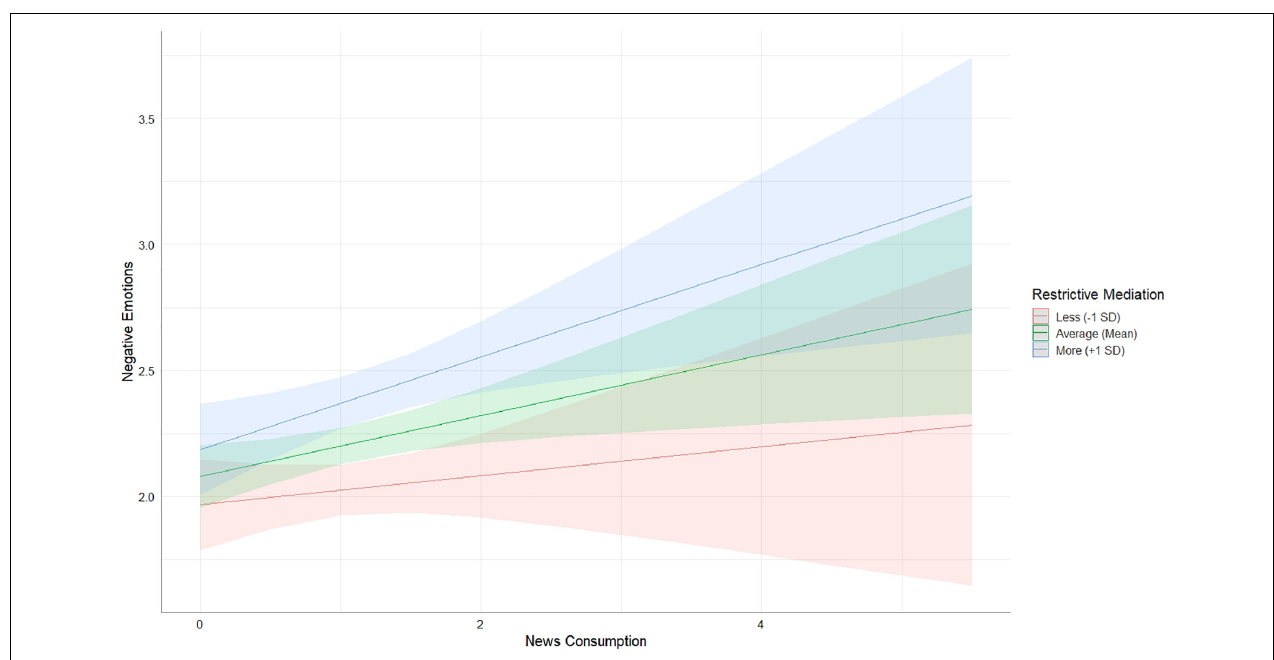
FIGURE 2 | Interaction between news consumption and restrictive mediation on negative emotions. To interpret and plot the interaction effects that emerged from the main analysis, the parental mediation measure was split into 3 levels of restrictive mediation (–1 SD, mean, and + 1 SD). This figure was created with package sjPlot (Lüdecke,